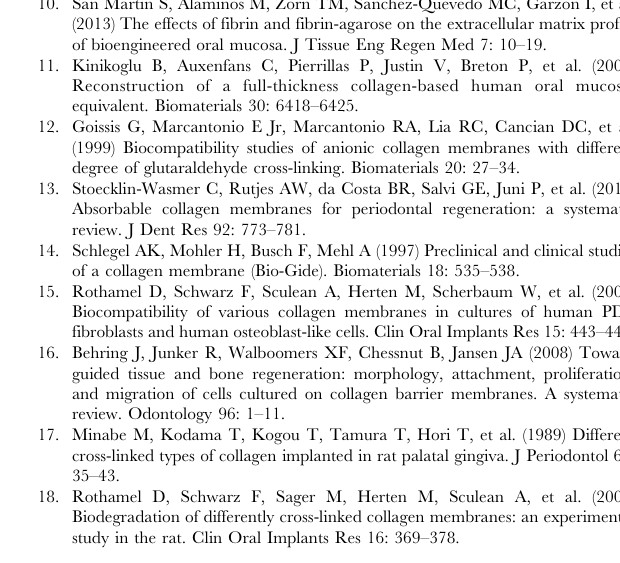
Table S4 Corresponding data on formazan formation of cells populating the gel type and sponge type scaffolds. Table S4 shows the corresponding data of figure 5. Table S5 Formazan formation of cells populating the gel type and sponge type scaffolds over time. Formazan formation in the gel type and sponge type scaffolds with and without platelet-derived growth factor-BB (PDGF) including the ‘‘active zone’’ at day 1, 4, 7, 10, 14 was quantified utilizing the MTT assay. Data are given as mean 6 standard deviation. (n= 6). Data was analyzed using analysis of variance (ANOVA) and Fisher’s protected least significant difference (PLSD) post hoc test. Significance (*) vs. the corresponding day 1 was assigned at p ,